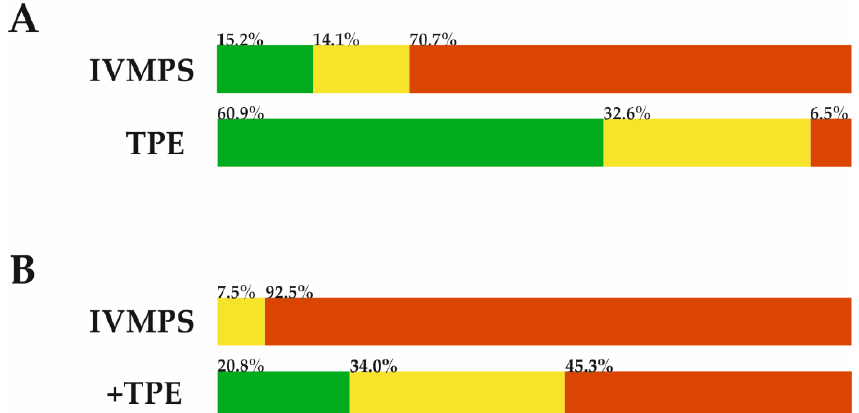
Figure 2. Different response groups following escalation treatment regimens are illustrated (green: good response; yellow: average response; red: worst response). (A) Upper bar represents patients who received IVMPS as the first escalation treatment ( n = 99). Lower bar represents patients who received TPE as the first escalation treatment ( n = 46). (B) Subgroup of patients who received two courses of escalation treatment ( n = 53). Upper bar shows treatment response after first escalation with IVMPS and lower bar represents results following second escalation with TPE.